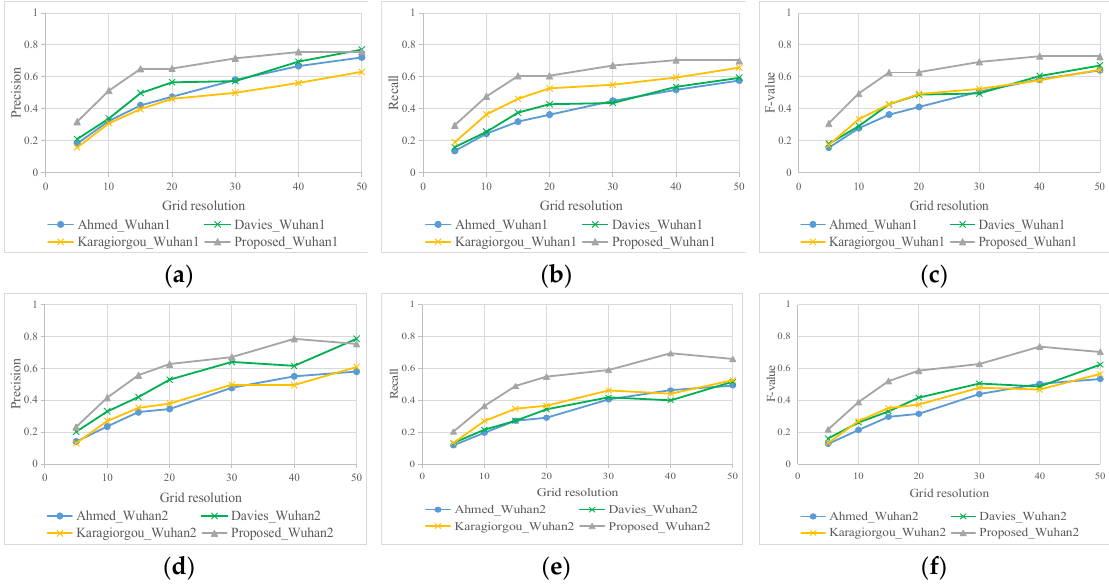
Figure 10. Quantitative comparisons of road extraction. ( a – c ) Wuhan dataset 1; ( d – f ) Wuhan dataset 2.